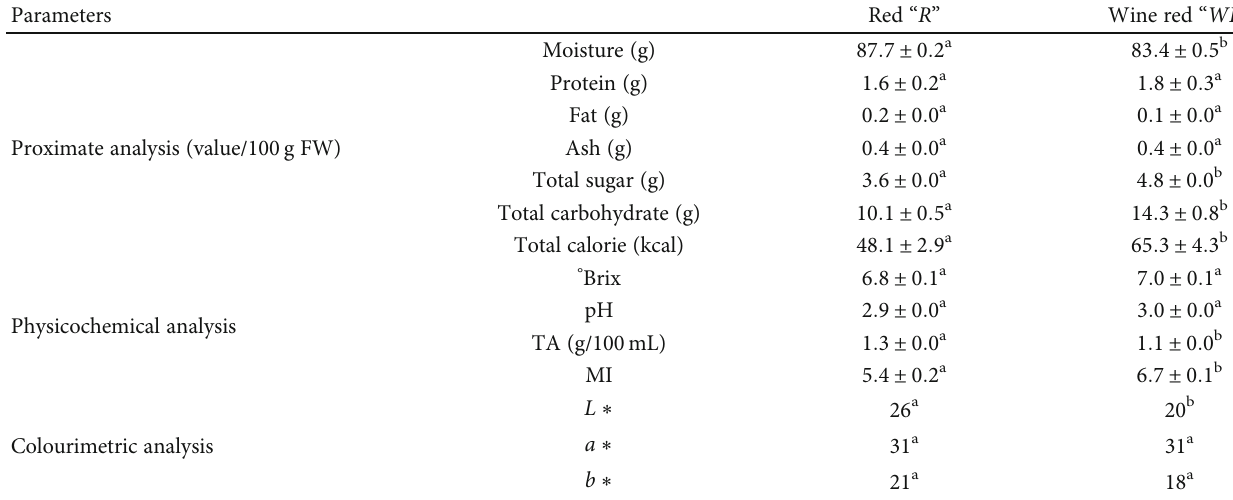
Table 2: Proximate, physicochemical, and colourimetric analyses of the Red “ R ” and Wine Red “ WR ” Rubus rosifolius varieties. Parameters Red “ R ”